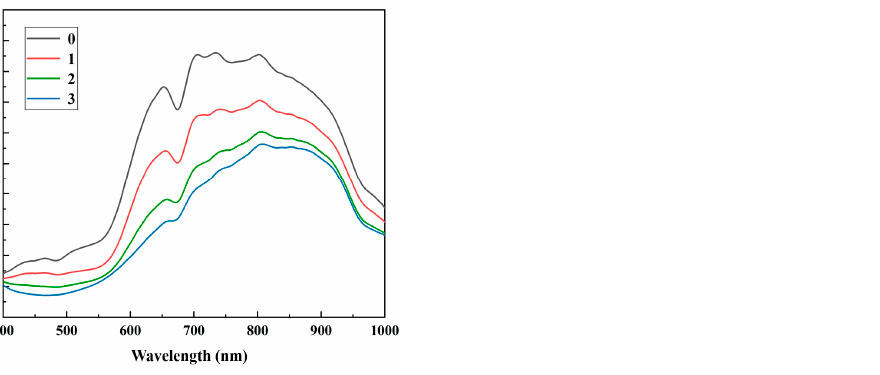
Figure 3. Spectra of apples with different infection degrees; 0: healthy, 1: mildly infected, 2: moder- ately infected, 3: severely infected.